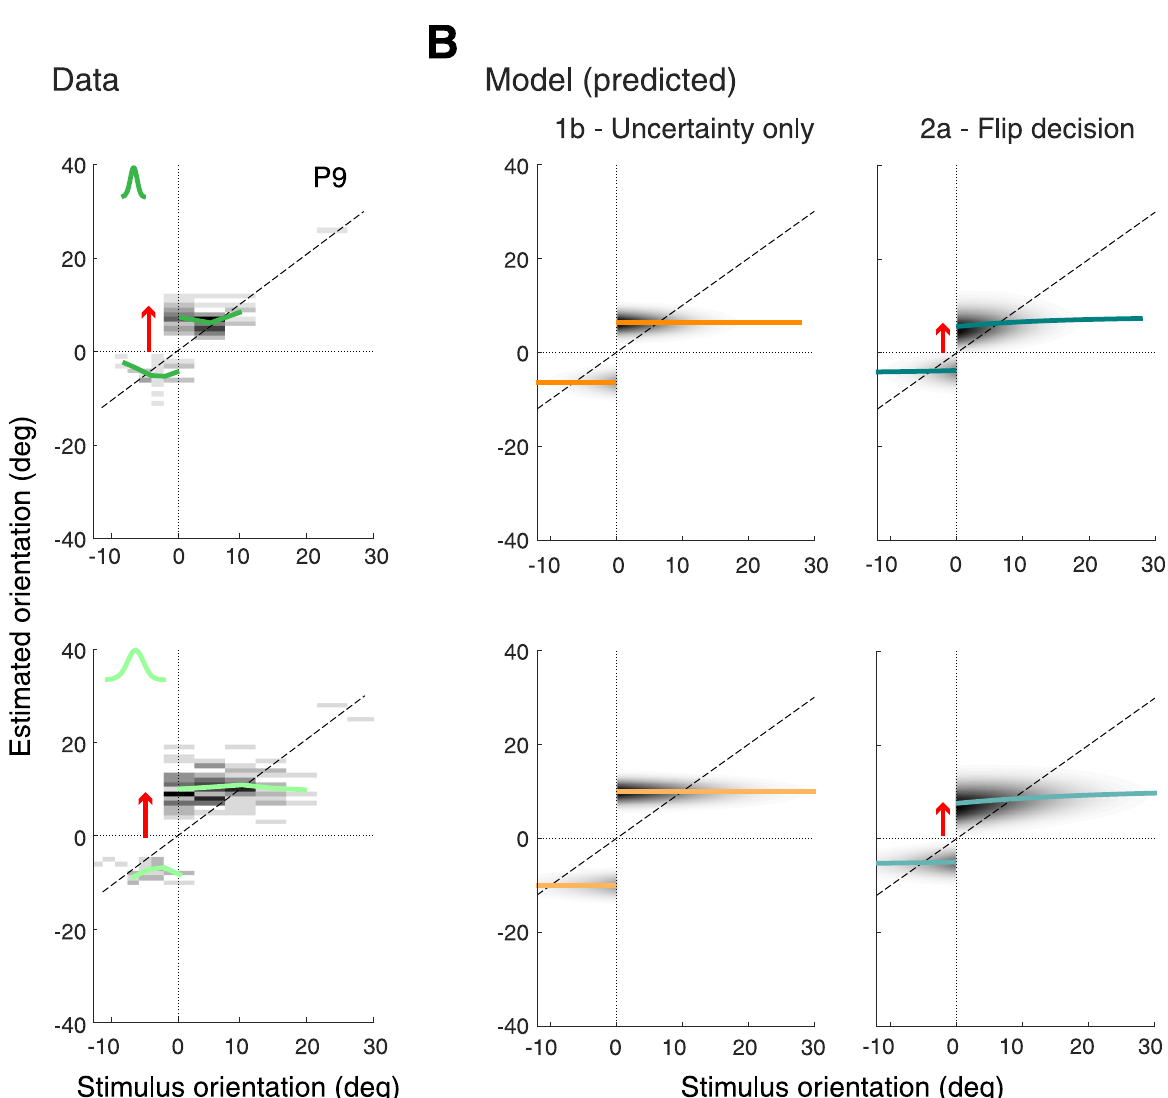
Fig 7. Experiment 2—Data and model predictions for incorrect trials. (A) Estimate distributions for incorrect trials (typical subject P9; see S4 Fig for data of all other subjects). As in Experiment 1, estimates are approximately constant and independent of stimulus orientation. However, the distributions show a clear asymmetry with estimates on the cw side being further away from the reference orientation than on the ccw side (red arrow). This pattern suggests that subjects were able to flexibly change and incorporate the correct prior in their estimate according to feedback. (B) Model 2a correctly predicts this asymmetry while Model 1b does not. Red arrows indicates the side with larger repulsive biases. Solid colored lines reflect mean estimates.